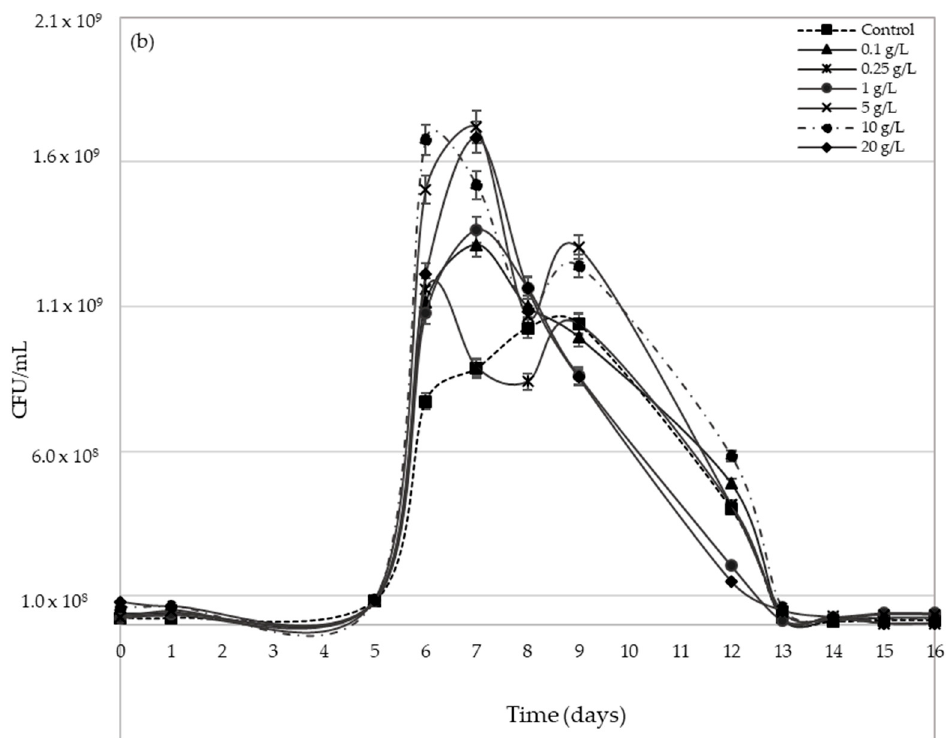
Figure 3. Evolution of the viable biomass of Saccharomyces cerevisiae yeasts during the alcoholic fermentation process of Palomino fino ( a ) and Riesling ( b ) grape must with bee pollen doses. The results are the mean ± SD of three repetitions.